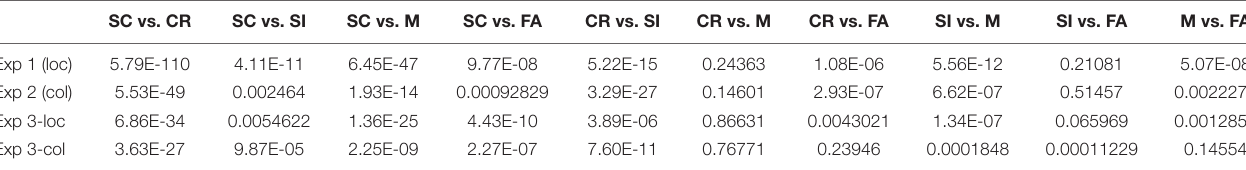
TABLE 3 | Comparison results between the classifier scores for the SC-CR classifier. SC vs. CR SC vs.